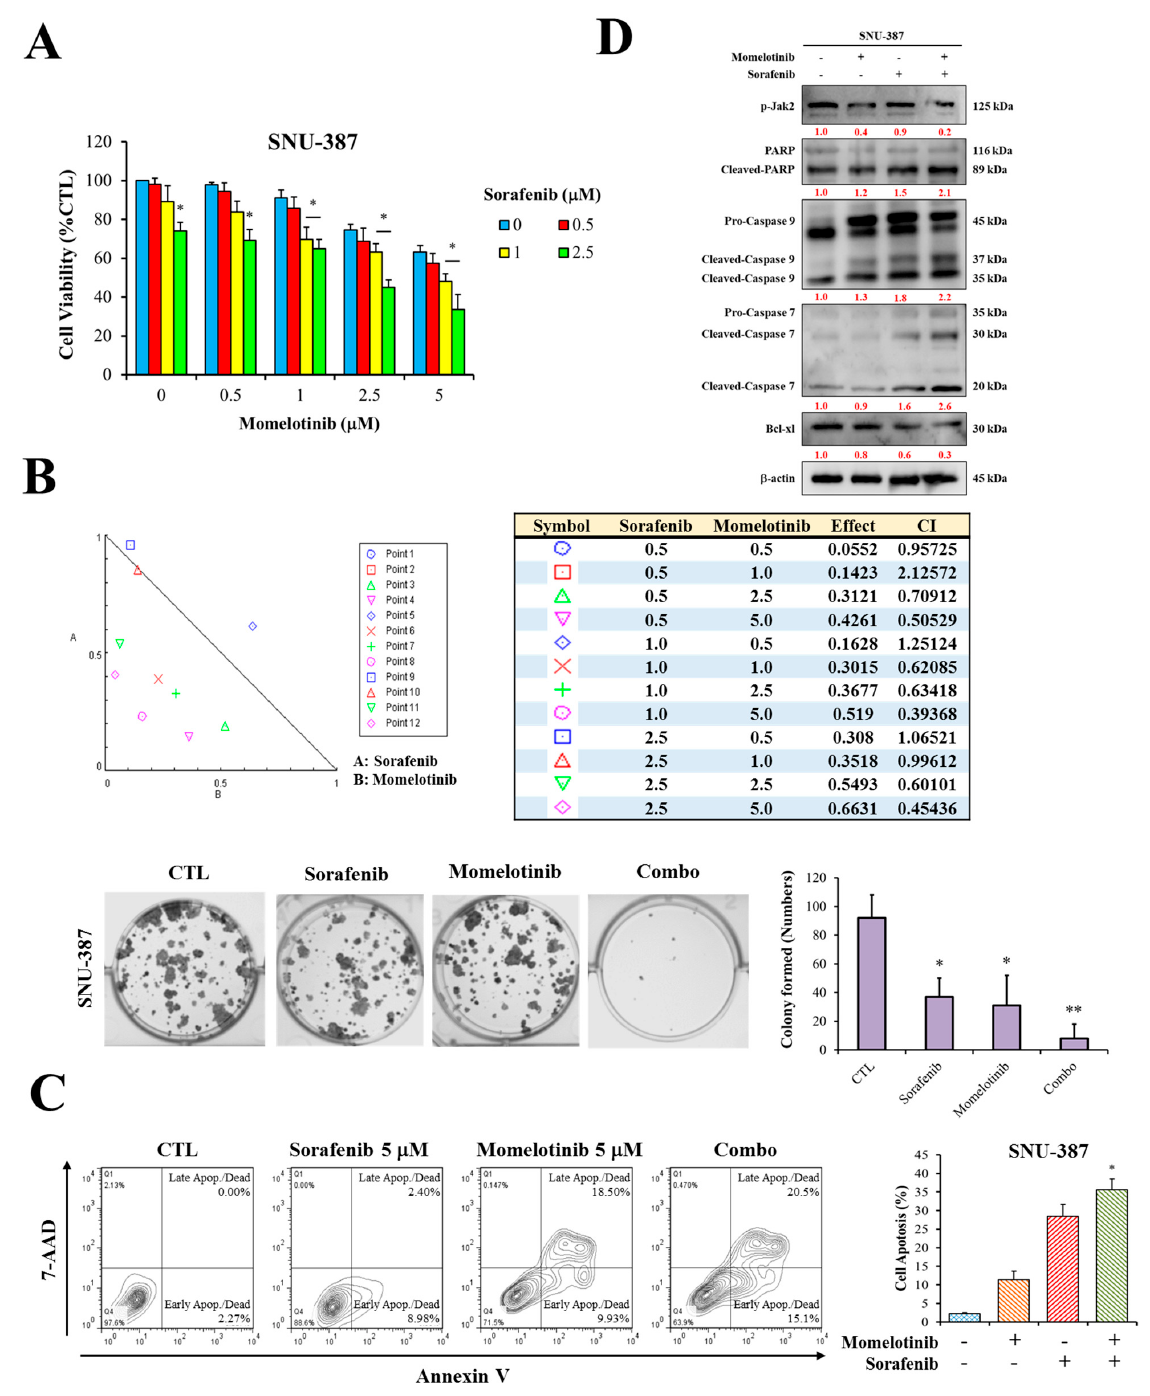
Figure 5. The combination of momelotinib and sorafenib suppressed the proliferation of vHCC cells. ( A ) Combination dose-dependent inhibition of vHCC cell line SNU-387 by sorafenib and momelotinib. ( B ) Synergistic effects of treatment with momelotinib–sorafenib combination on SNU-387 cells, and the effect of treatment on the colony-forming capacity of SNU-387 cells. Combination propensity and effect were evaluated using CompuSyn based on the Chou–Talalay algorithm for drug combination. Combinational effects are presented as the combination index (CI), where a CI of <1 (inside the triangle) indicates synergism, a CI of 1 (on the hypotenuse) indicates an additive effect, and a CI of >1 (outside the triangle) indicates antagonism. ( C ) Apoptosis analysis by flow cytometry for Annexin-V+ and 7-AAD-stained cells, indicating elevated apoptosis in cells treated with the combination. ( D ) Representative western blot images of apoptosis markers in SNU-387 cells. β -actin was used as a loading control. * p < 0.05; ** p <